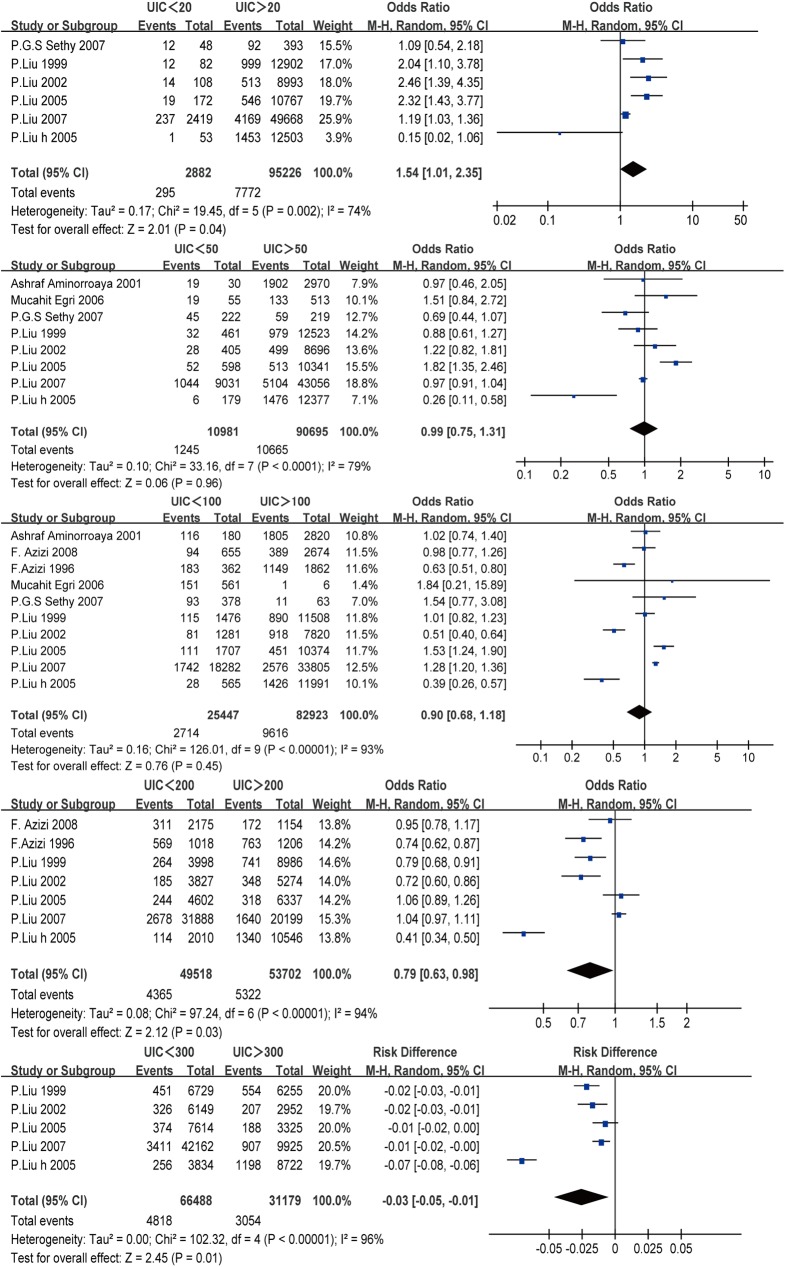
Forest plot showing the comparison of goiter prevalence in different UIC categories.